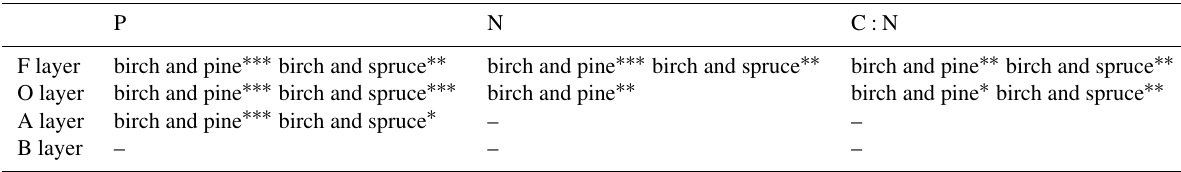
Table C2. Statistical differences of soil elements in each soil layer of different plots, grouped by their dominant tree species. Levels of